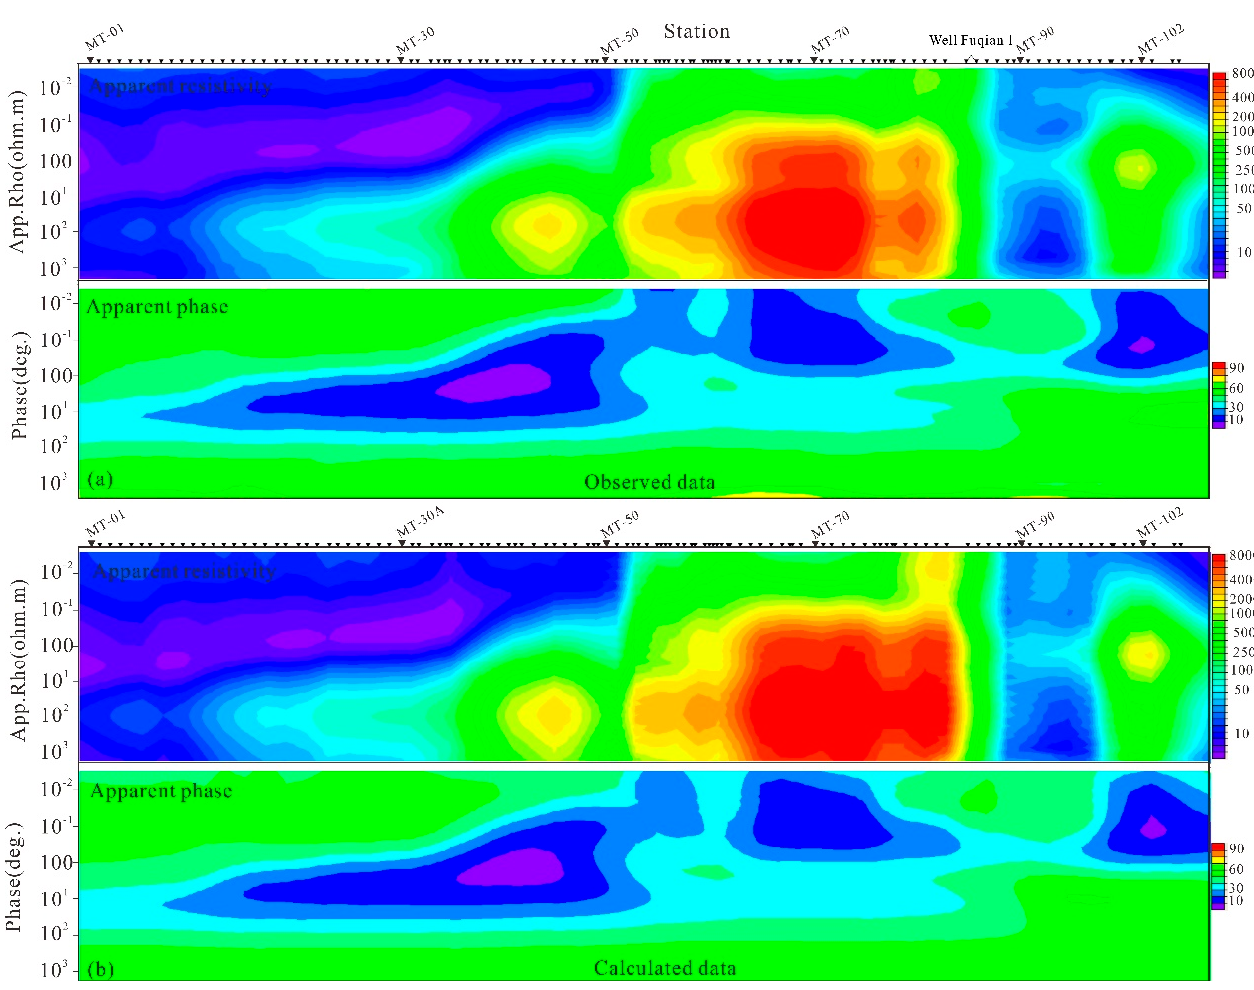
Figure 6. ( a ) Observed apparent resistivity and phase in pseudo section format for the profile. ( b ) Response of the 2D model. The similarities between pseudo sections of observed and calculated data prove the final model is reliable.